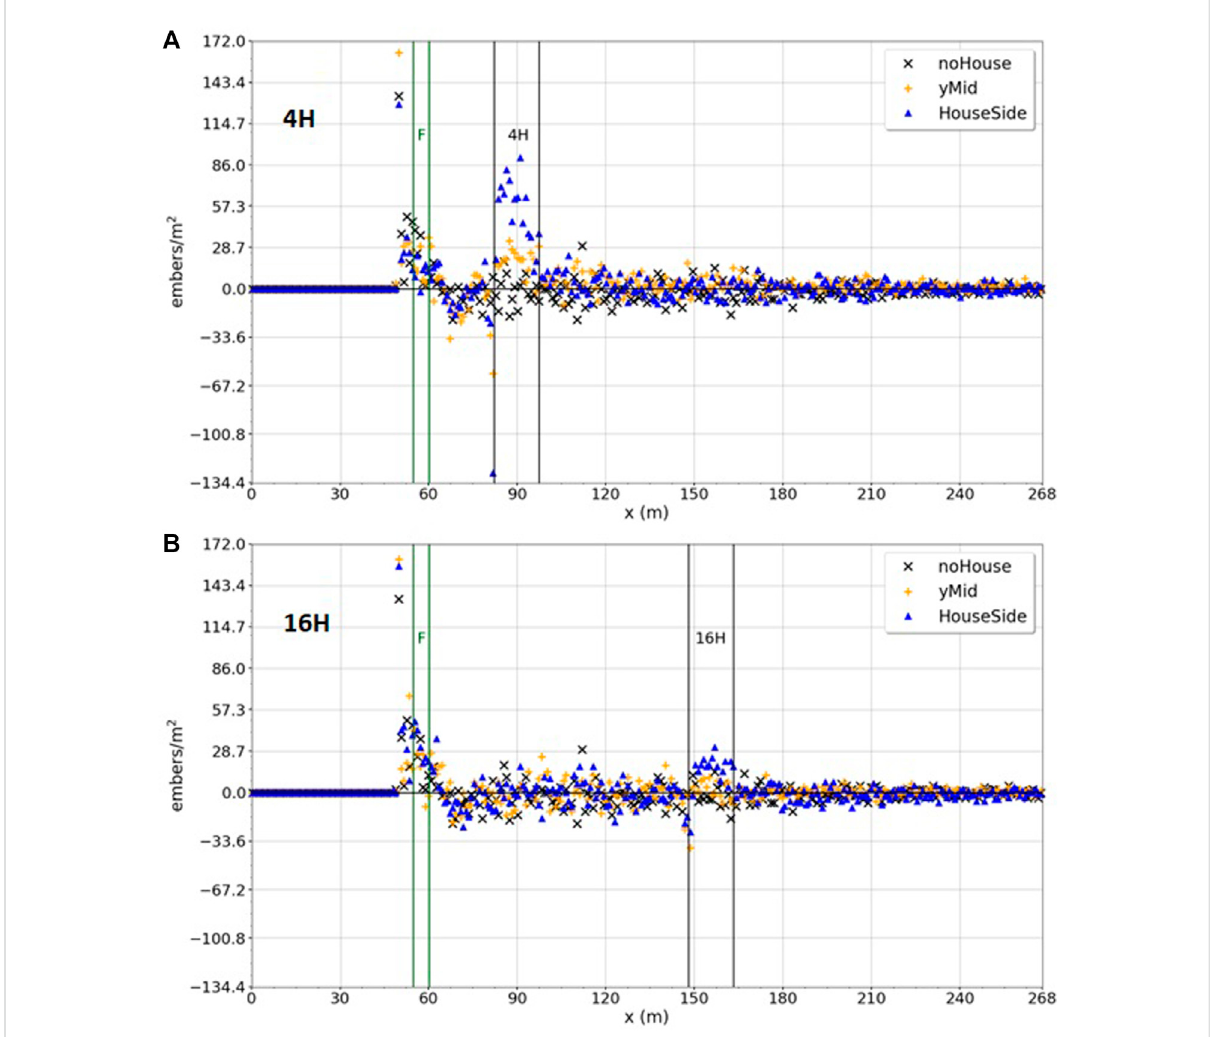
FIGURE 7 Differences in fi rebrand deposition with a fence vs . without along two transects down the middle of the domain for the base cases. The vertical lines near x = 60 m indicate the fence location. The vertical lines near 90 and 150 m indicate the house locations. Black ‘ X ’ s: deposition along a transect running down the middle of the domain when no house is present. Gold ‘ + ’ s: deposition along a transect running down the middle of the domain, through the centerline of the house. Blue triangles: deposition along a transect running along the side of the house. Positive numbers: increased deposition at a given location when a fence is present. Negative numbers: decreased deposition at a given location when a fence is